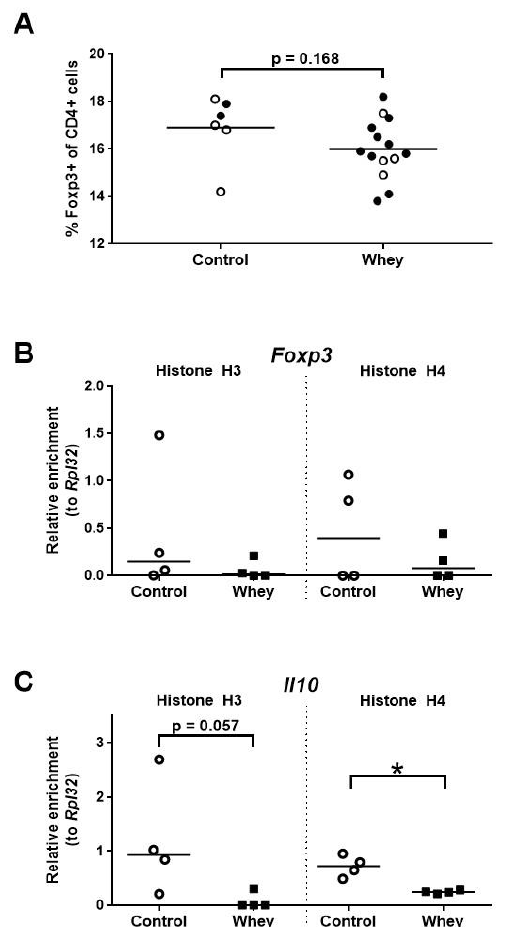
Figure 6. A confirmed allergic response to whey protein was associated with a tendency towards a lower percentage of spleen Treg cells and decreased H4 histone acetylation levels at the interleukin 10 gene. ( A ) The percentage of CD4 + T cells positive for forkhead box P3 (Foxp3) as assessed by flow cytometry. Data are presented as a scatter dot plot showing individual data points and mean. Open circles indicate the mice that were included in the histone modification analysis. Data of one mouse in the control group was excluded due to a technical error. Comparisons were performed with an unpaired t test. Histone acetylation levels at the Foxp3 gene ( Foxp3 ) ( B ) and the interleukin 10 gene ( Il10 ) ( C ) in spleen-derived CD4 + T cells as determined by chromatin immunoprecipitation followed by qPCR. Data are presented as scatter dot plots showing individual data points and median. Comparisons were performed with a Mann–Whitney U test. * p < 0.05; p -values ≥ 0.05 and < 0.2 are shown as